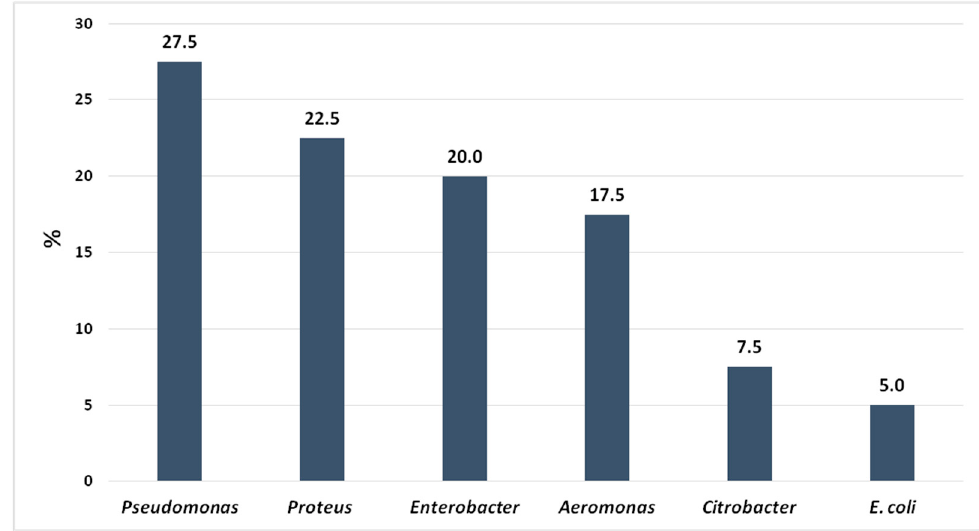
Figure 3. Percentages of the bacterial genera and E. coli detected in wastewater samples.